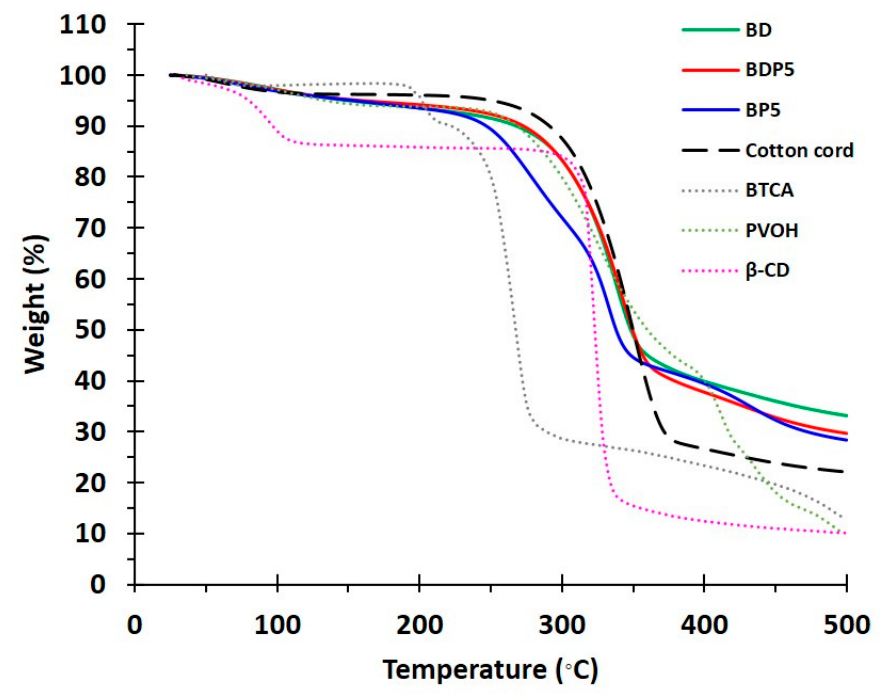
Figure 3. TGA thermograms of β− CD, PVOH, BTCA, cotton cord, BP5, BDP5, and BD.